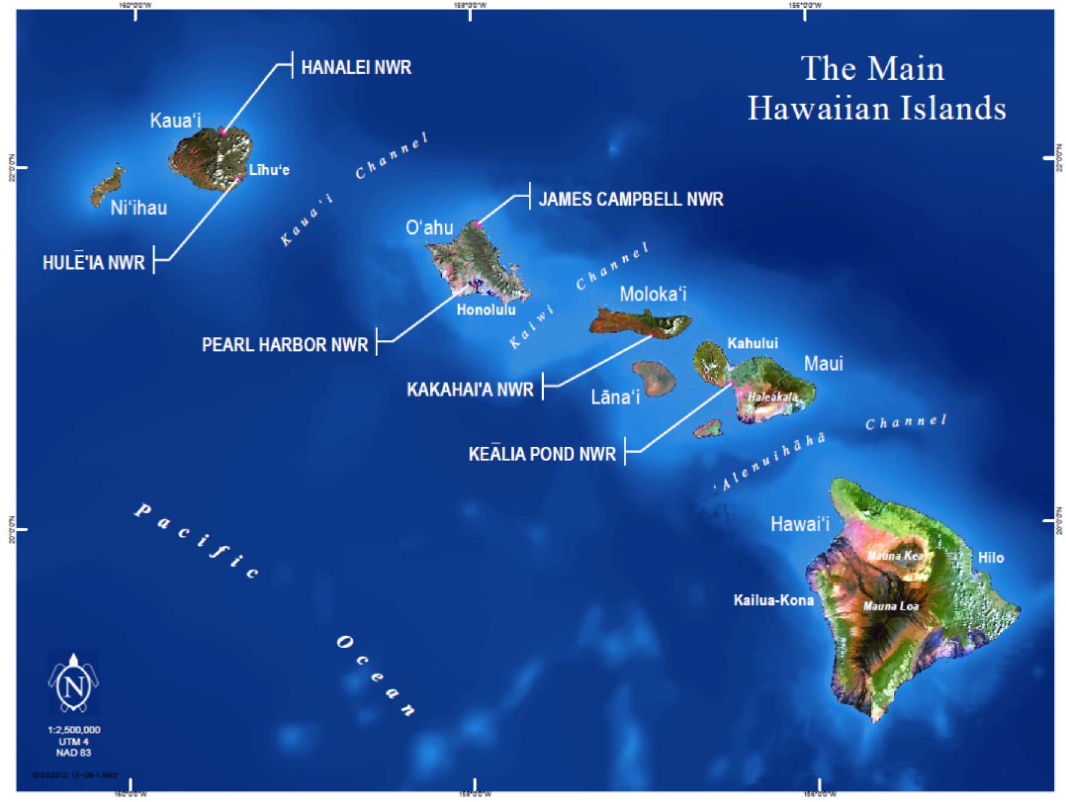
Figure 1. Map of ‘‘Main Hawaiian Islands’’ with the six coastal plain national wildlife refuges identified. Hawai’i, USA.